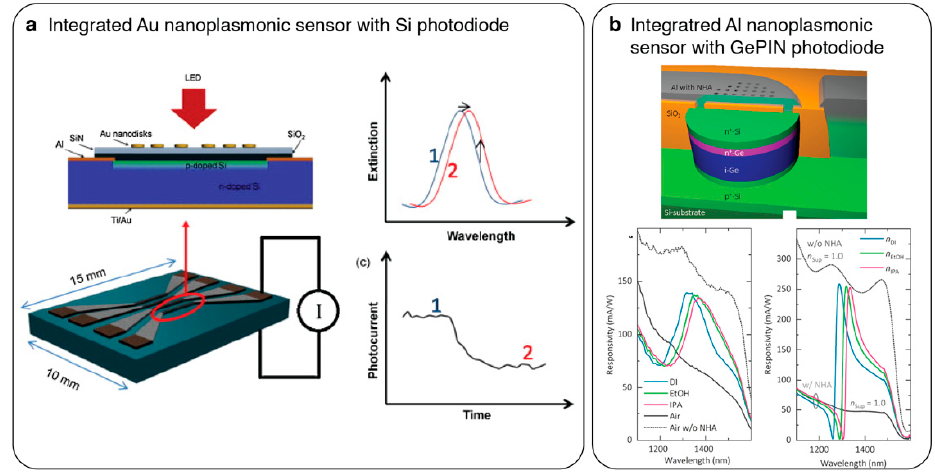
Figure 11. Integrated nanoplasmonic sensor and photon detector systems enabling direct conversion of optical detection signals into electrical signals. ( a ) Plasmonic nanodisks are directly fabricated on Si photodiodes. When illuminated with a LED light source, the change in transmission is measured as photocurrent based on the intensity interrogation technique. Reprinted from [102], Copyright 2010, with permission from Elsevier; ( b ) CMOS compatible Al nanoholes are patterned on Ge PIN photodiode. Adapted with permission from Ref. [107] Copyright 2011 American Chemical Society.